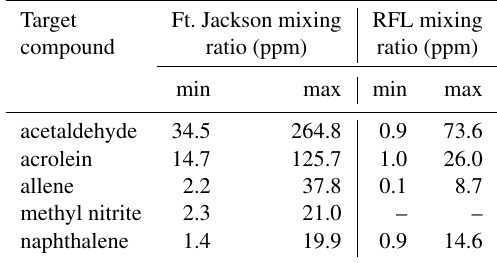
Table 3. Calculated minimum and maximum mixing ratios (ppm) for the 10 canister measurements taken at Ft. Jackson (Scharko et al., 2019b), along with the minimum and maximum mixing ratios (ppm) for the 10 static measurements during the RFL laboratory experiment with acetaldehyde, acrolein, allene, methyl nitrite, and